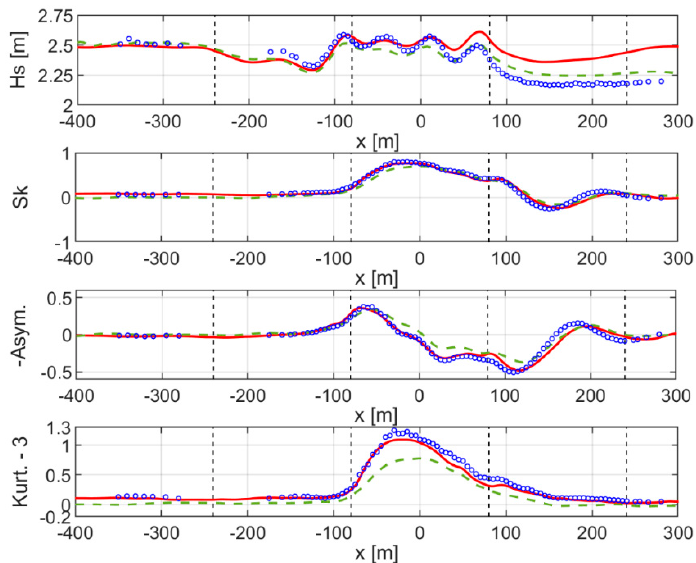
Figure 8. For H2.5T11, the comparison with measurements (blue circle) of simulated statistical quantities in the shoal area where measurement data are available. From top to bottom Hs, Skewness, Asymmetry and excess Kurtosis. Simulations of 1D long-crested results are shown by the red-solid line; the green dashed line is the result of simulations of short-crested waves with a spreading of 20 degrees.